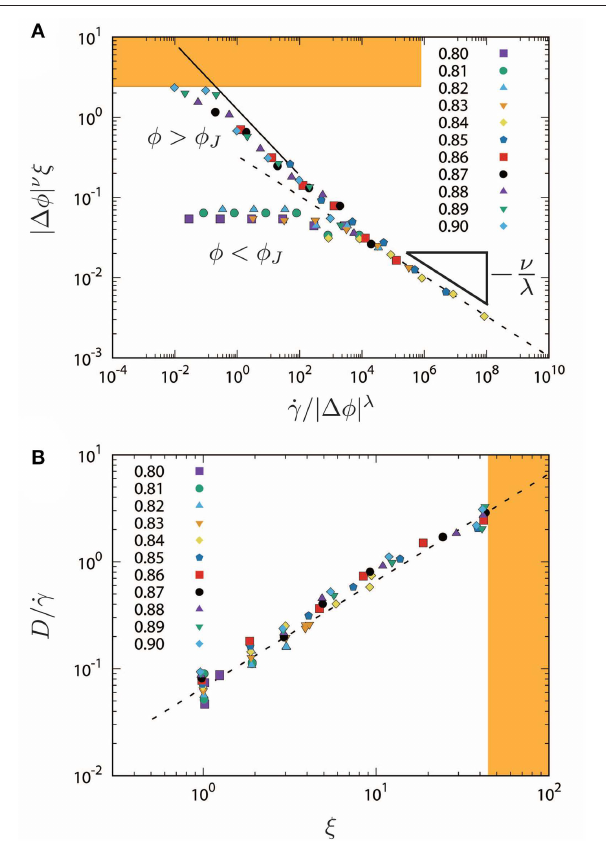
λ = 4.0, are the same with those in Figure 3B . If the shear FIGURE 5 | (A) Scaling collapses of the length scale ξ , where 1φ ≡ φ − φ